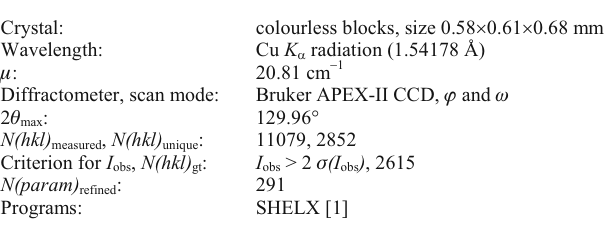
Table 2. Atomic coordinates and displacement parameters (in Å 2 )